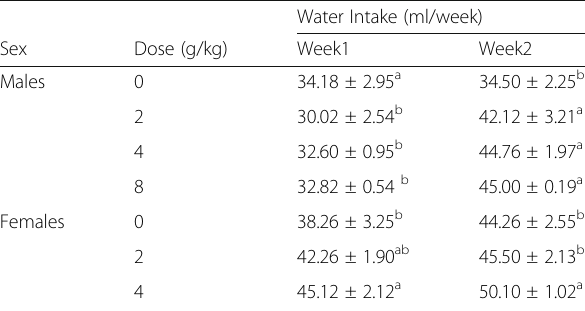
Table 3 Evolution of water consumptions of rats after single administration of the aqueous extract from A. cordifolia